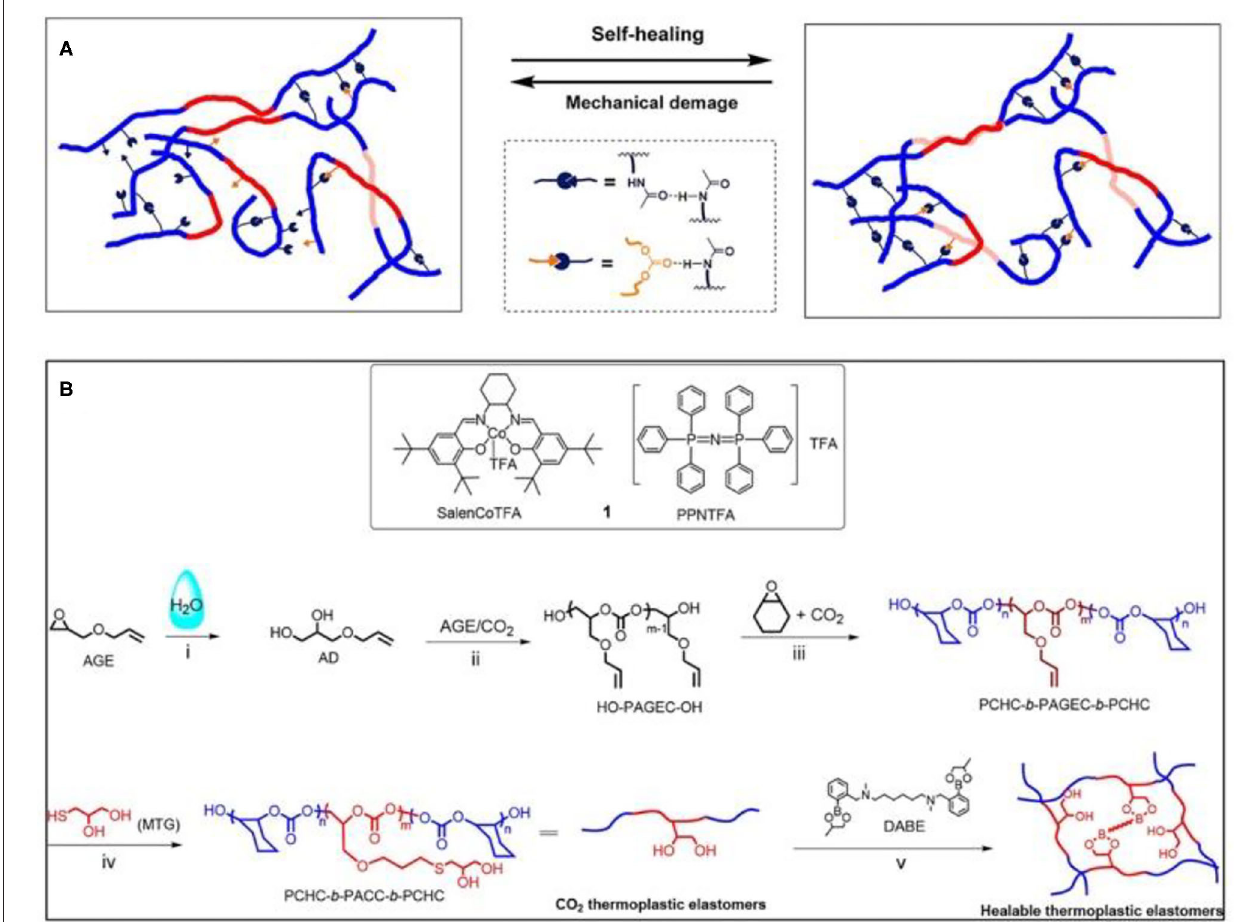
FIGURE 15 | (A) Schematic illustration of the self-healing mechanism of the CO 2 -based block copolymers (Yang et al., 2018). Adapted with permission from Yang et al. (2018) . Copyright 2018 American Chemical Society. (B) SalenCoTFA/PPNTFA catalyst system and tandem strategy performed for the preparation of CO 2 -based healable thermoplastic elastomers ( Yang and Wu, 2019). Adapted with permission from Yang and Wu (2019). Copyright 2019 American Chemical Society.